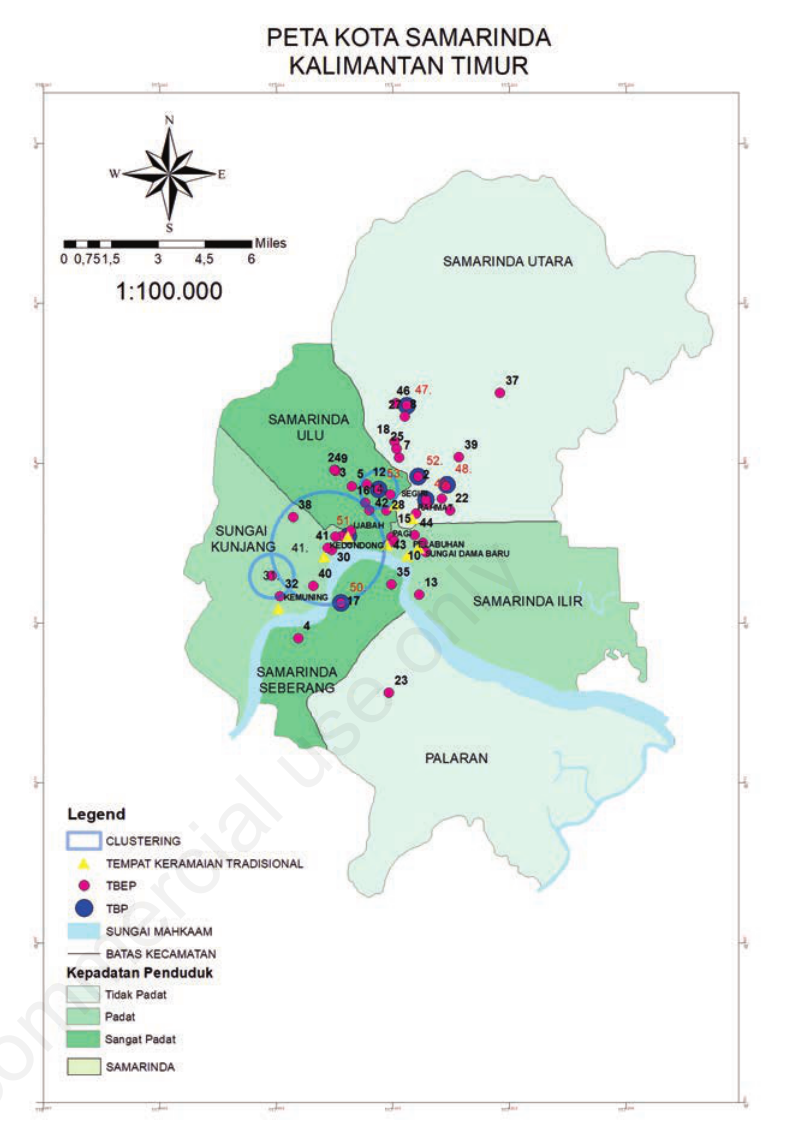
Figure 1. Spatial and pattern distribution of EPTB in Samarinda City. SaTScan Space- Time Permutation model analysis showed 3 clustering of TBEP. Cluster 1 consisted of